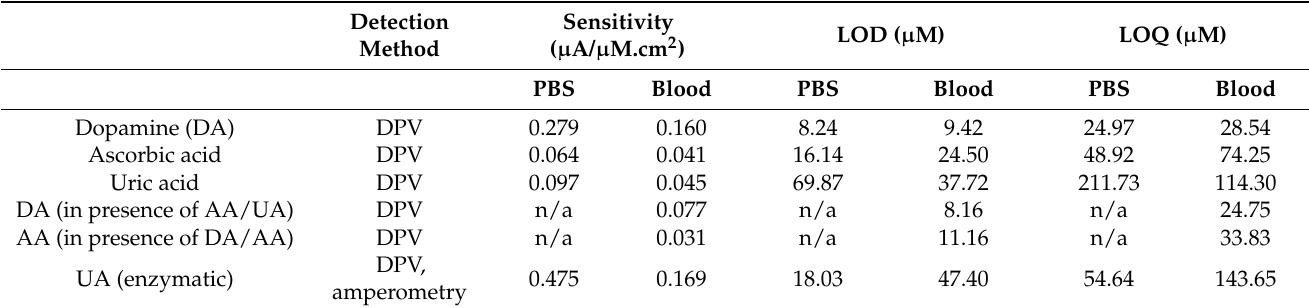
Table 1. Analytical parameters of the micropatterned O3ES.